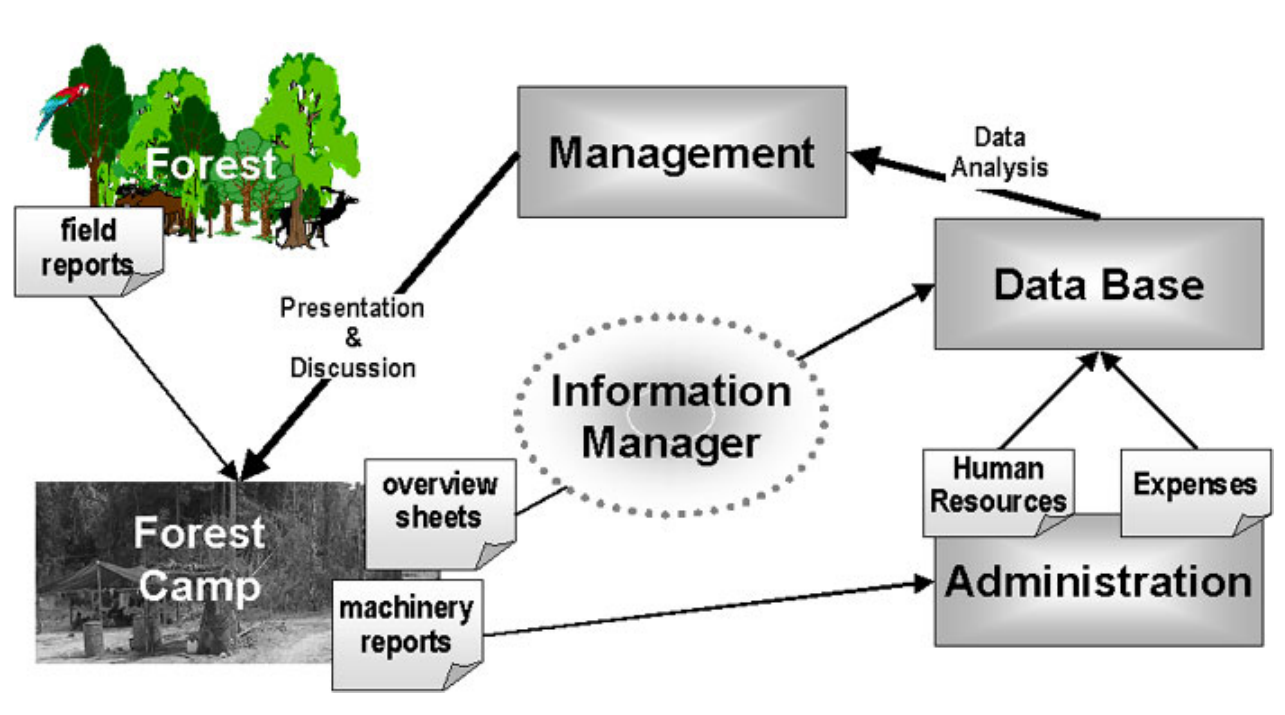
Fig. 1 . Schematic of collaborative monitoring